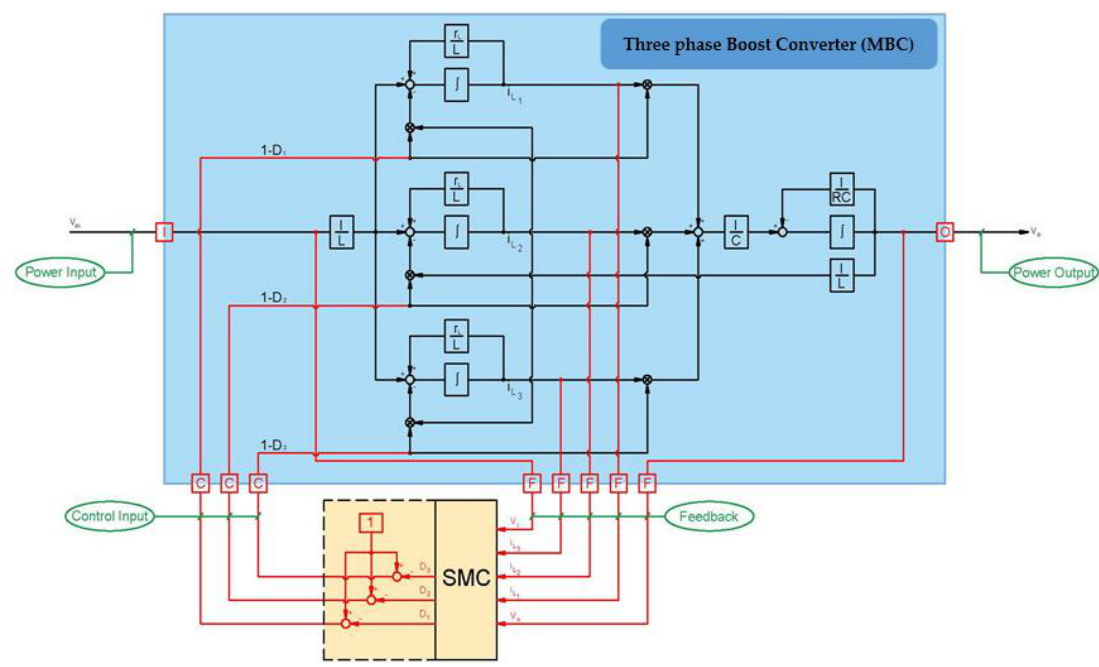
Figure 4. Block diagram of three phase boost converter with sliding mode controller (SMC).